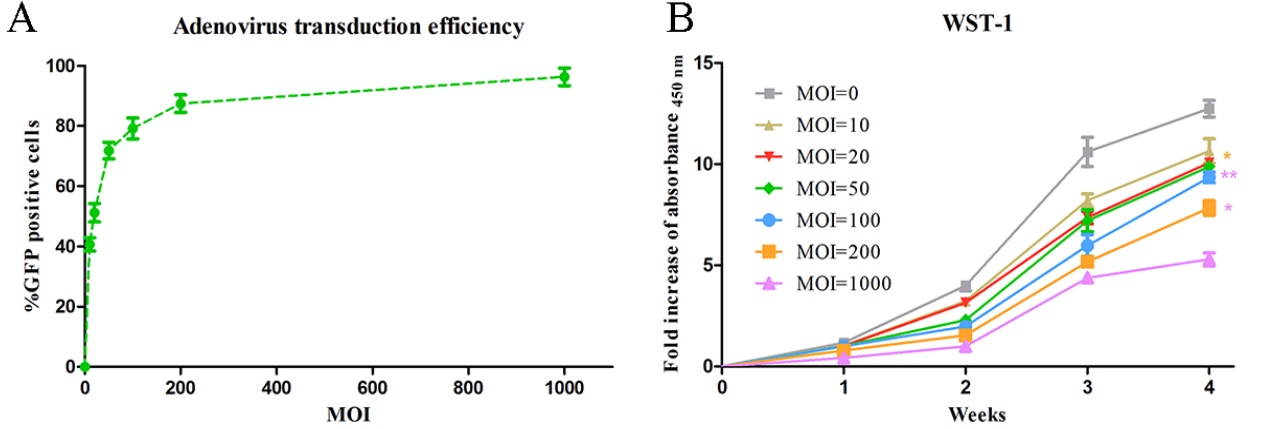
Figure 1. Transduction efficiency and proliferation of hADSCs transduced with adenovirus: ( A ) Summary result of adenoviral transduction efficiency using different MOI. ( B ) WST-1 measurement of hADSCs transduced with adenovirus using different MOI. Values given represent means ± SE, * for p < 0.05, and ** for p < 0.01.